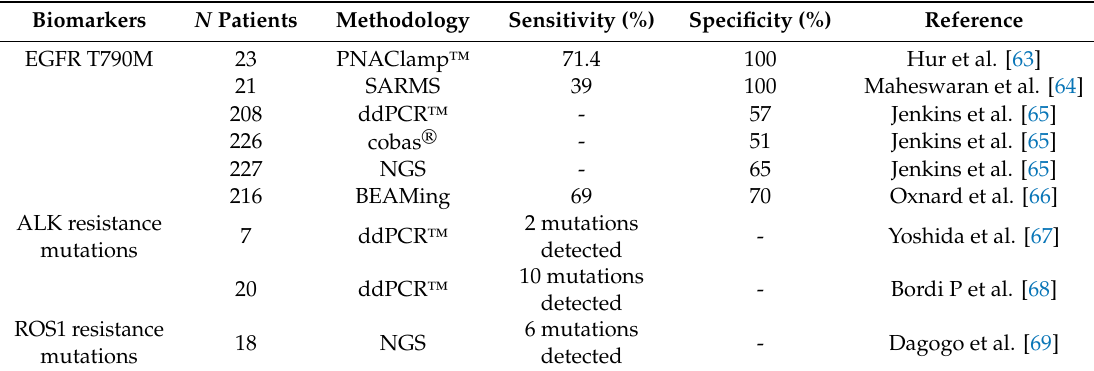
Table 1. Principal resistance biomarkers detectable by cell free DNA